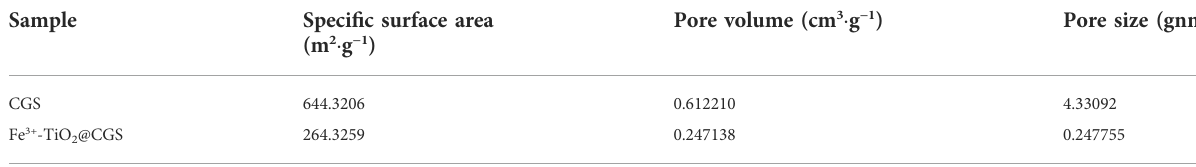
TABLE 2 Speci fi c surface area and pore structure parameters of gasi fi cation